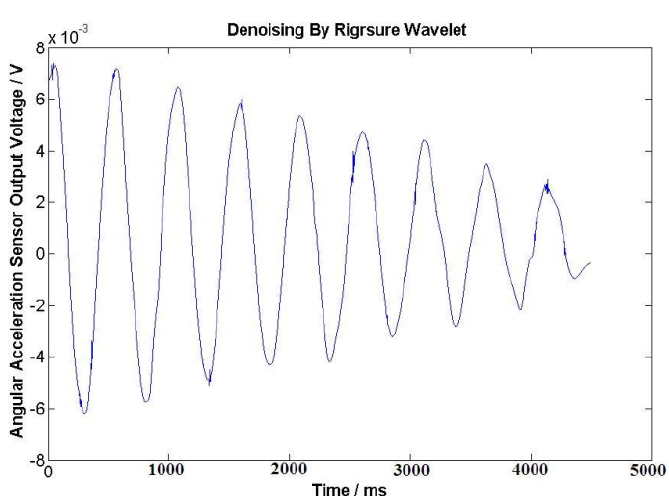
Figure 11. The de-noised signals by Rigrsure wavelet.